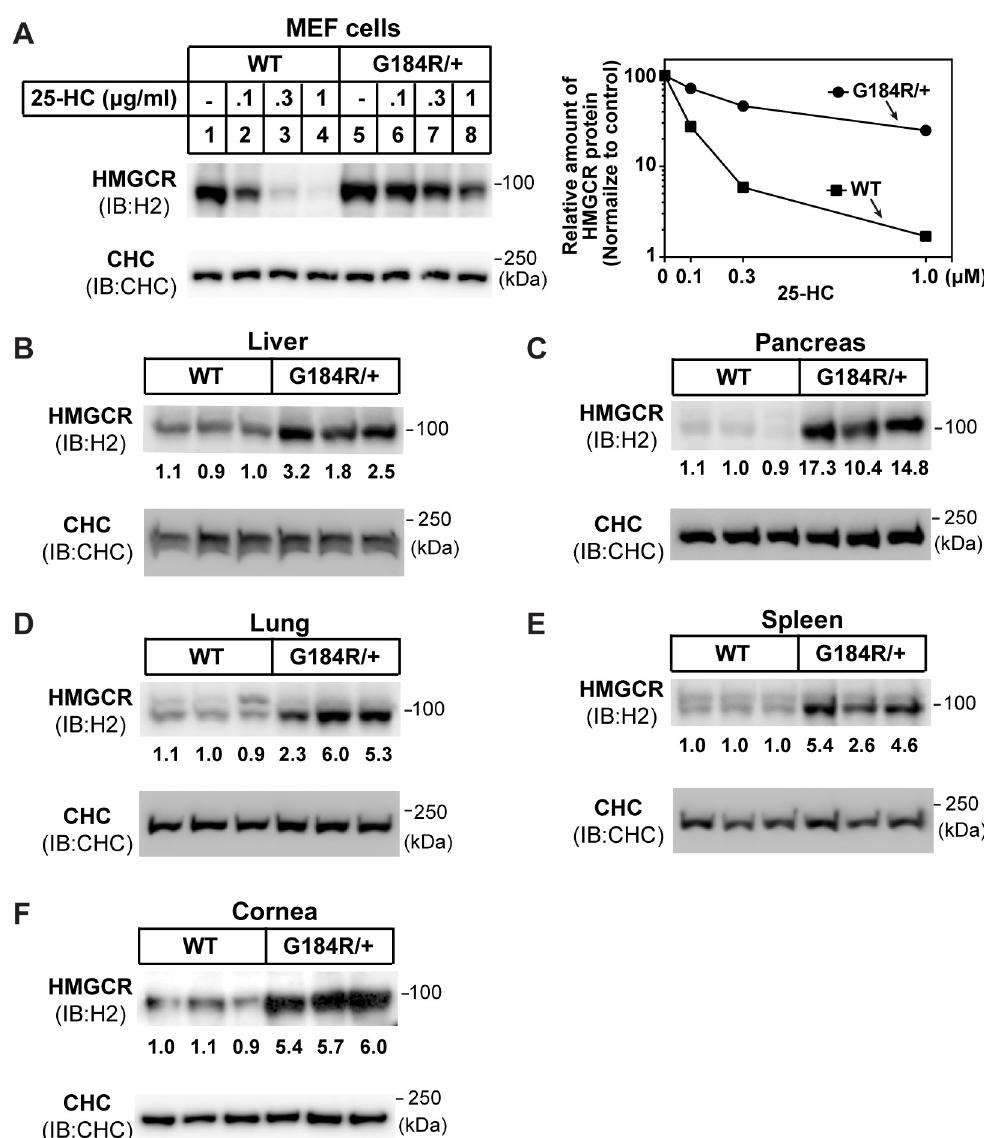
Fig 6. Accumulation of HMGCR protein in tissues of Ubiad1 G184R/+ mice. (A) Regulation of HMGCR in mouse embryonic fibroblasts (MEFs) from WT and Ubiad1 G184R/+ embryo. MEF cells were isolated and depleted of sterols in medium containing 10% LPDS, 1 μ M lovastatin, 50 μ M mevalonate for 16 hr, then indicated concentrations of 25-HC were added. After 5 hr incubation, cells were harvested for immunoblot analysis with rabbit polyclonal H2 (against HMGCR) and CHC. Clathrin heavy chain (CHC) was a loading control. The relative amount of HMGCR protein was quantified with Image-Pro Plus 6 software, and normalized to the CHC loading control. The normalized intensity of HMGCR band in WT MEF without 25-HC was defined as 100. (B-F) Male aged (102-week to 108-week old) WT and Ubiad1 G184R/+ littermates were fed ad libitum with chow diet before sacrifice. Tissues were harvested and membrane fractions were extracted, then immunoblotted with H2 (against HMGCR) and CHC antibodies. The HMGCR protein levels of WT and Ubiad1 G184R/+ mice in liver (B), pancreas (C), lung (D), spleen (E) and cornea (F) were immunoblotted, quantified and normalized to CHC loading control. The average amount of normalized HMGCR protein in WT group was defined as 1. The experiments are repeated three times and representative data are